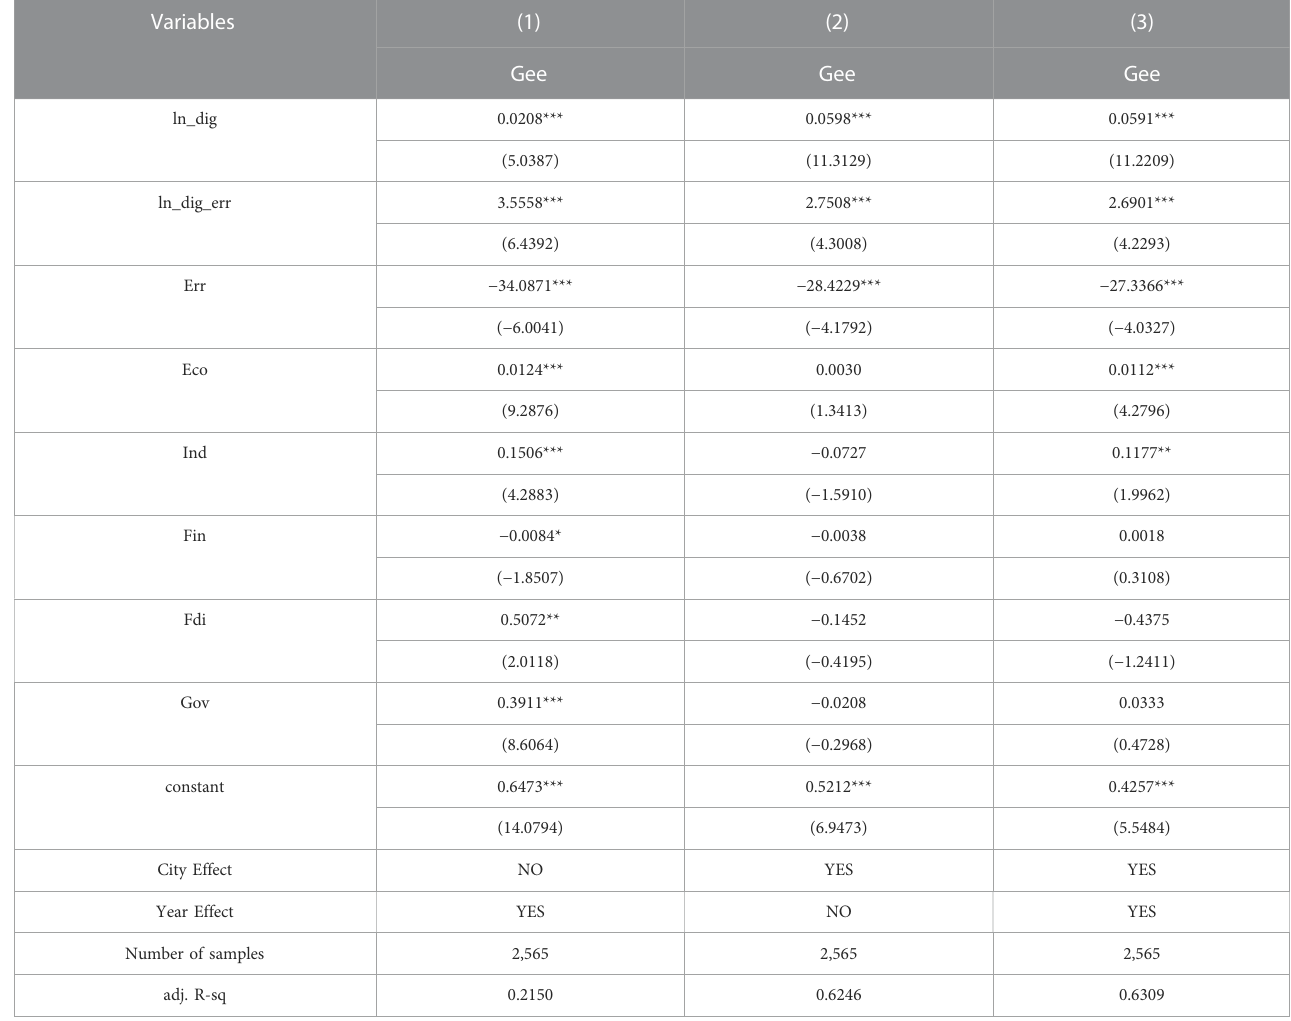
TABLE 4 Regression results of moderation